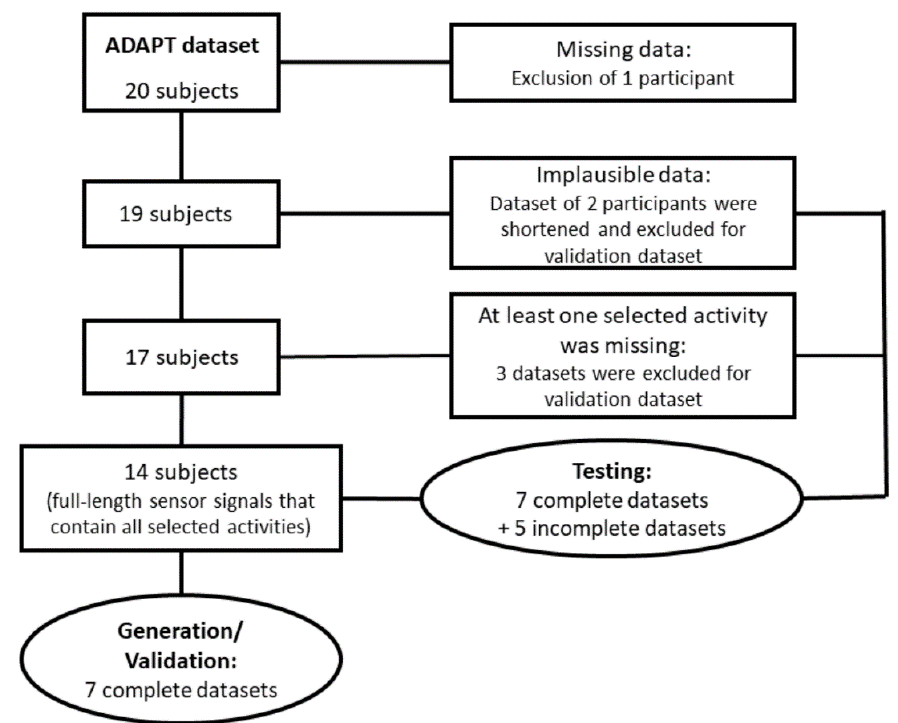
Figure 1. Flow chart of the data selection and allocation process.